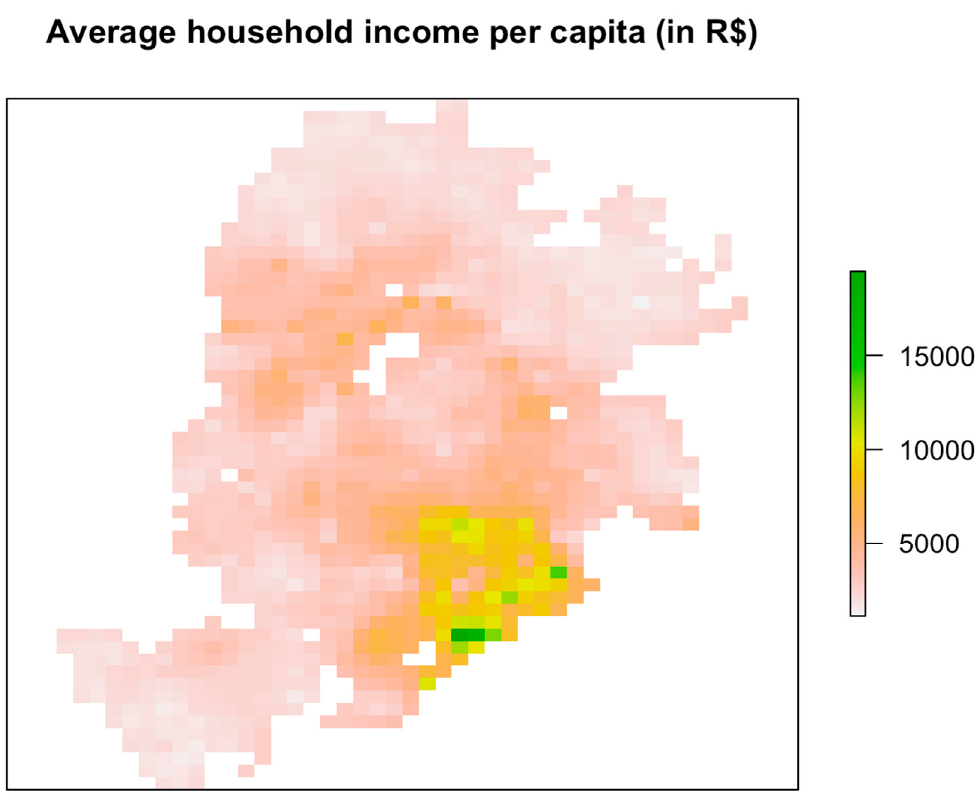
Figure 1. Average household income per capita (in Brazilian reais).